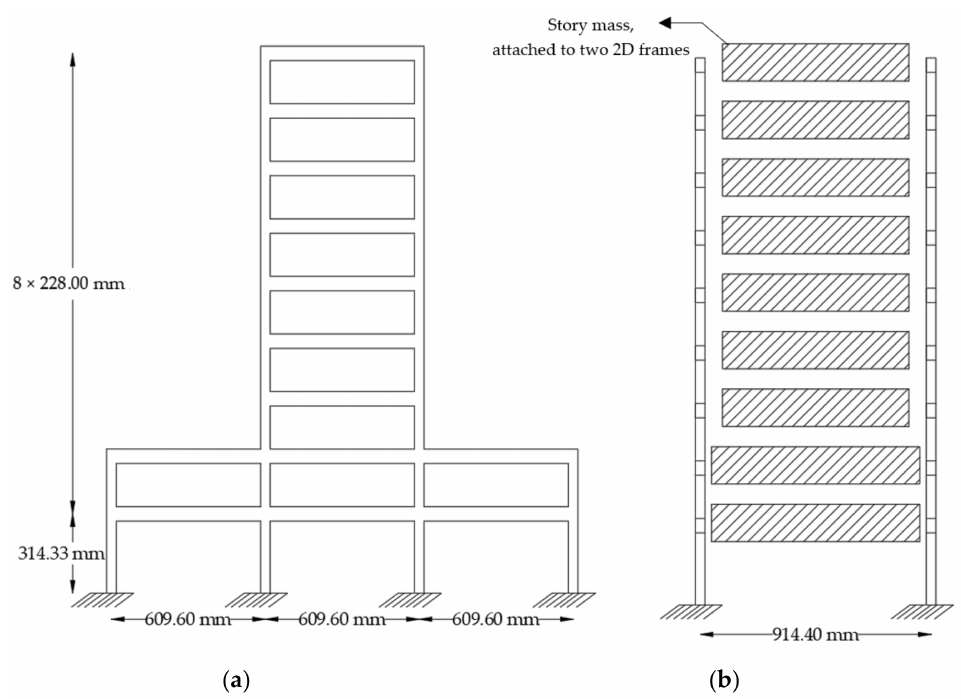
Figure 5. Experimental test specimen of towered setback structure: ( a ) front view, and ( b ) side view.